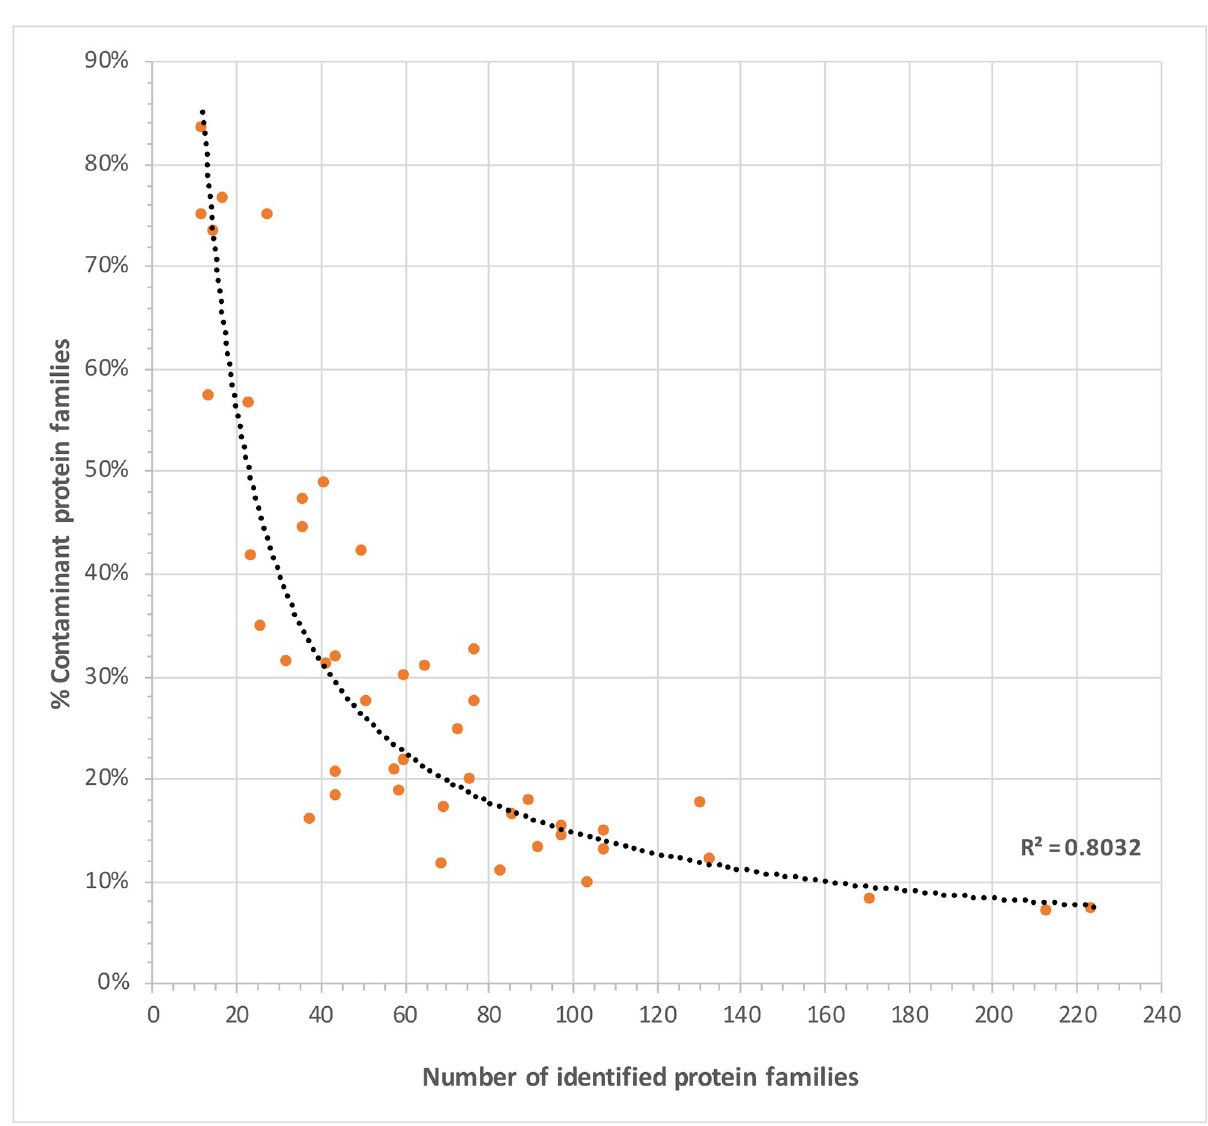
Fig 9. Scatterplot displaying the correlation between the total number of identified protein families and the proportion of putative contaminant proteins. Samples with relatively low numbers of proteins overall are dominated by contaminants (predominantly keratins), which could be due to sample handling or general low abundance of endogenous